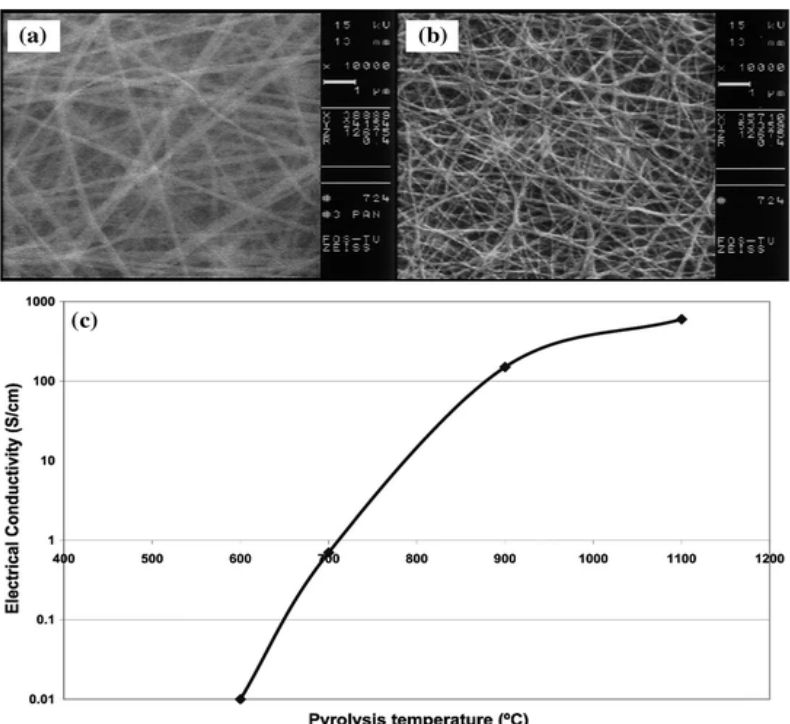
Figure 22. SEM images of ( a ) PAN, ( b ) carbon nanofibers without a gold coating, and ( c ) pyrolysis temperature versus conductivity. Reproduced from [157] with the permission of John Wiley and Sons.